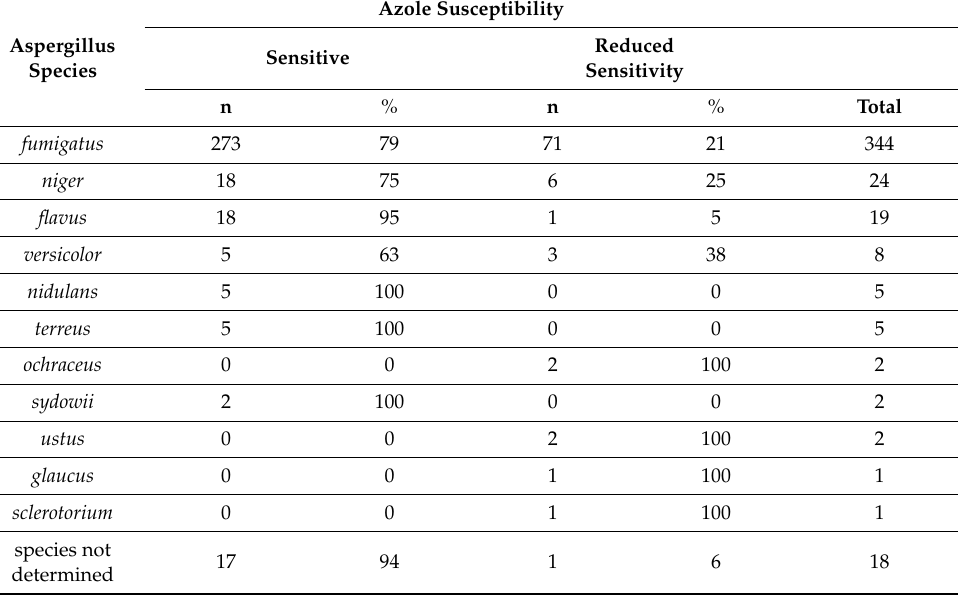
Table 1. Aspergillis fumigatus is the most commonly cultured species (80%) with an azole susceptibility of